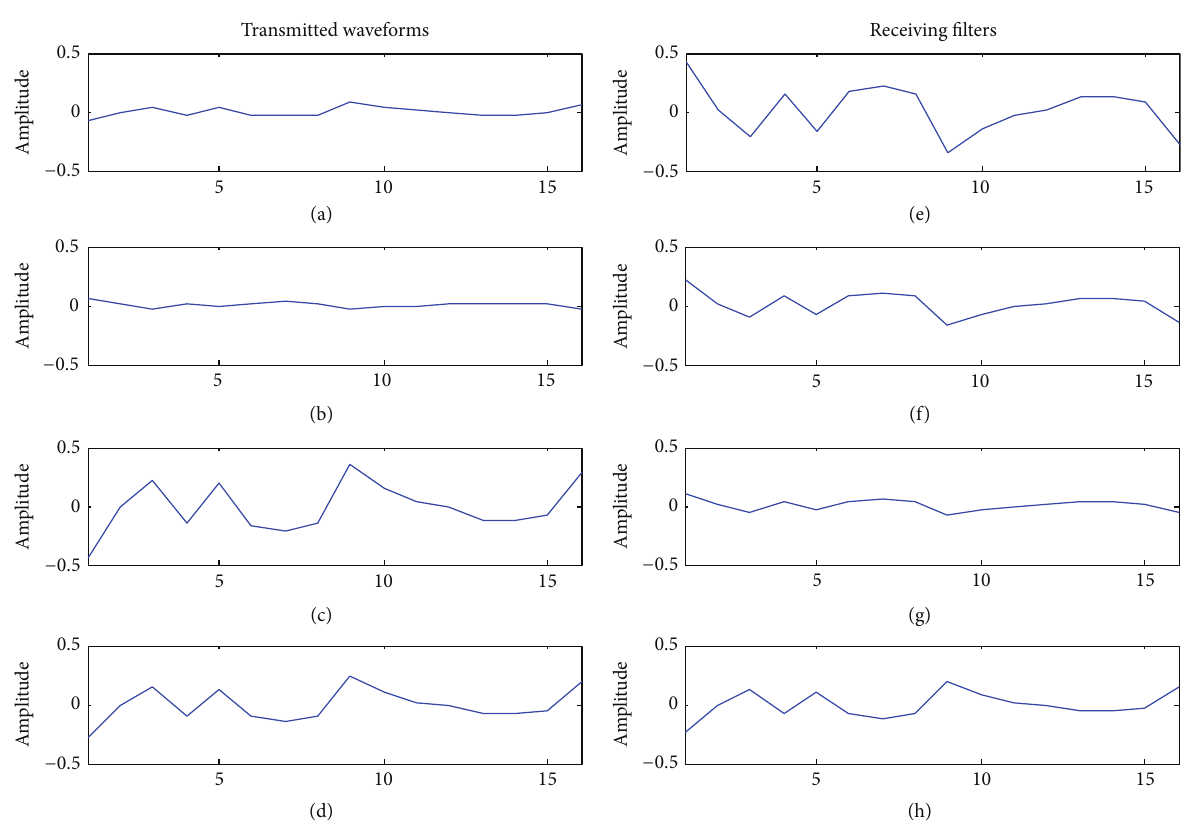
versus iterative number. It can be found that the SCNR in each step of the proposed iterative algorithm is nondecreasing and rapid convergence of the method is guaranteed. The optimized transmitted waveforms and receiving filters are shown in Figure